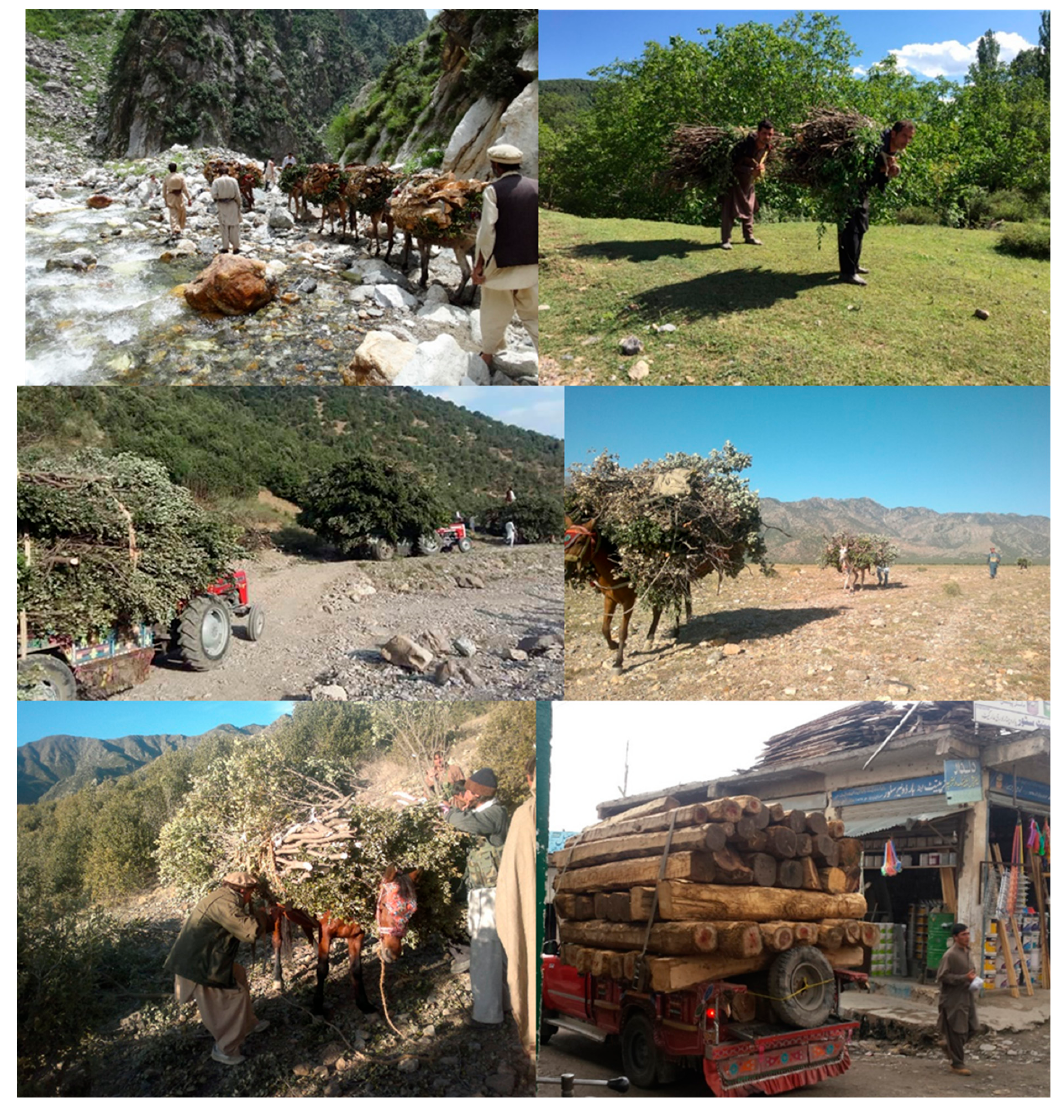
Figure 5. Forest harvesting and transporting mechanisms in different villages of District Kurram. Source: Photos in different parts of Kurram Valley © Kamal Hussain, between 2015 and 2019 The disintegration of joint families has further accelerated the pressure on forest re- sources, as in most cases nuclear and joint families consumed an almost equal amount of wood with little differences. In Kurram valley, the customary laws allow each household an equal amount of wood extraction during the stipulated period of wood collection [40]. Households have increased by 315.1% from 1972 to 2017 in District Kurram (Table 7). The new households also get equal rights of wood collection. Therefore, with the increase in population and number of households, the pressure on forest resources has increased many folds which resulted in an ongoing deforestation process.